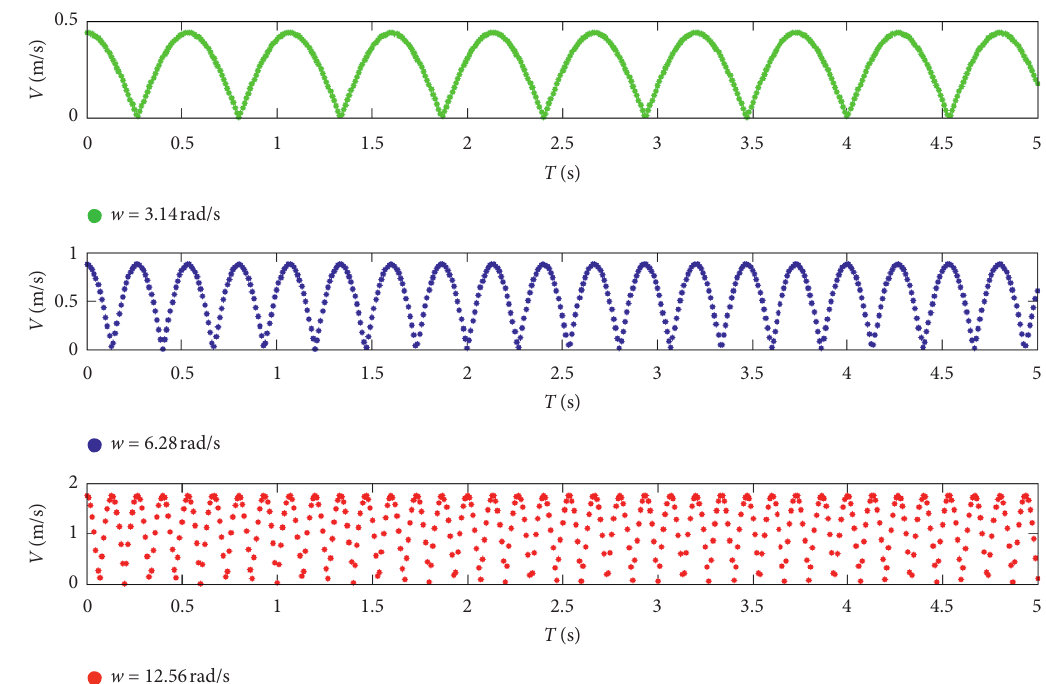
Figure 5: Schematic diagram of the change in velocity of point P when time t � 1–5 s.